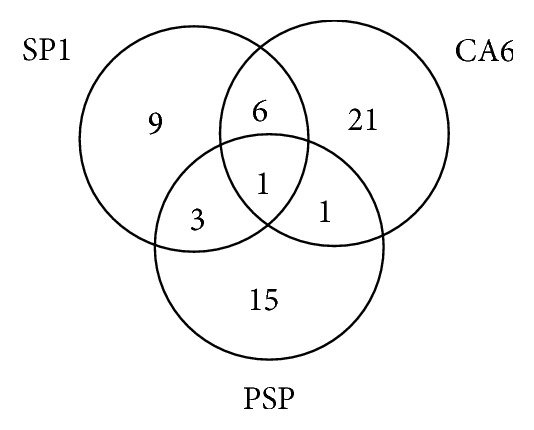
Venn diagram showing the number of patients with positive novel autoantibody.